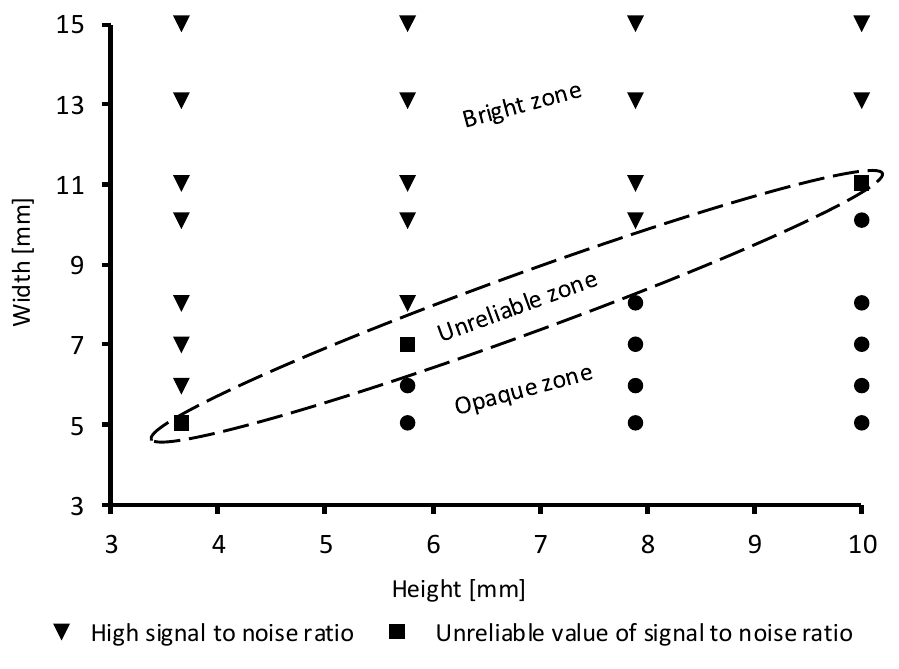
Figure 8. Tested height-width combination of the PDMS chambers. Three zones are identified: Bright, opaque and unreliable